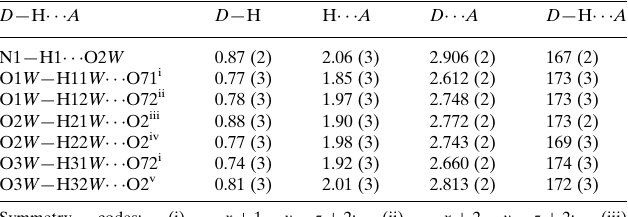
Hydrogen-bond geometry (A˚ , (cid:3)